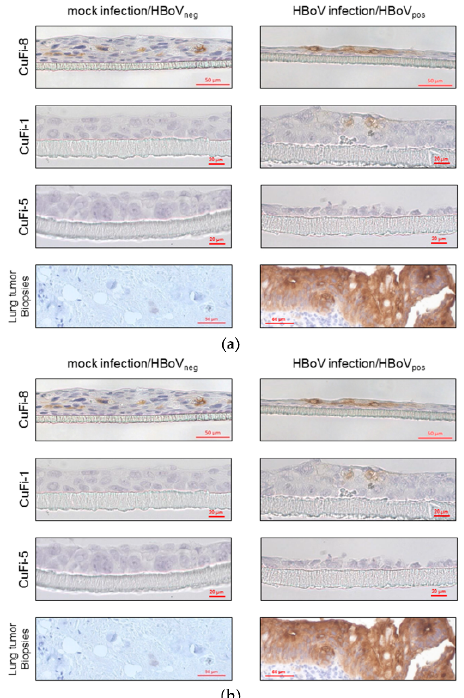
Figure 3. Immunohistochemical staining of CuFi-8 air–liquid-interface cultures. ( a ) Scheme 8. cells and HBoV-positive lung tumor biopsies, whereas mock-infected CuFi-8 cultures, as well as HBoV- negative lung tumors, were CEA-negative. CuFi-1 and Cufi-5 cells were not CEA-positive at all. ( b ) PAS–Alcian blue staining reveals higher production of acid mucins in CuFi-8 cells compared to those in CuFi-1 and CuFi-5 cells in general. Beyond that, there is an increased expression of acid mucins after HBoV infection in CuFi-8